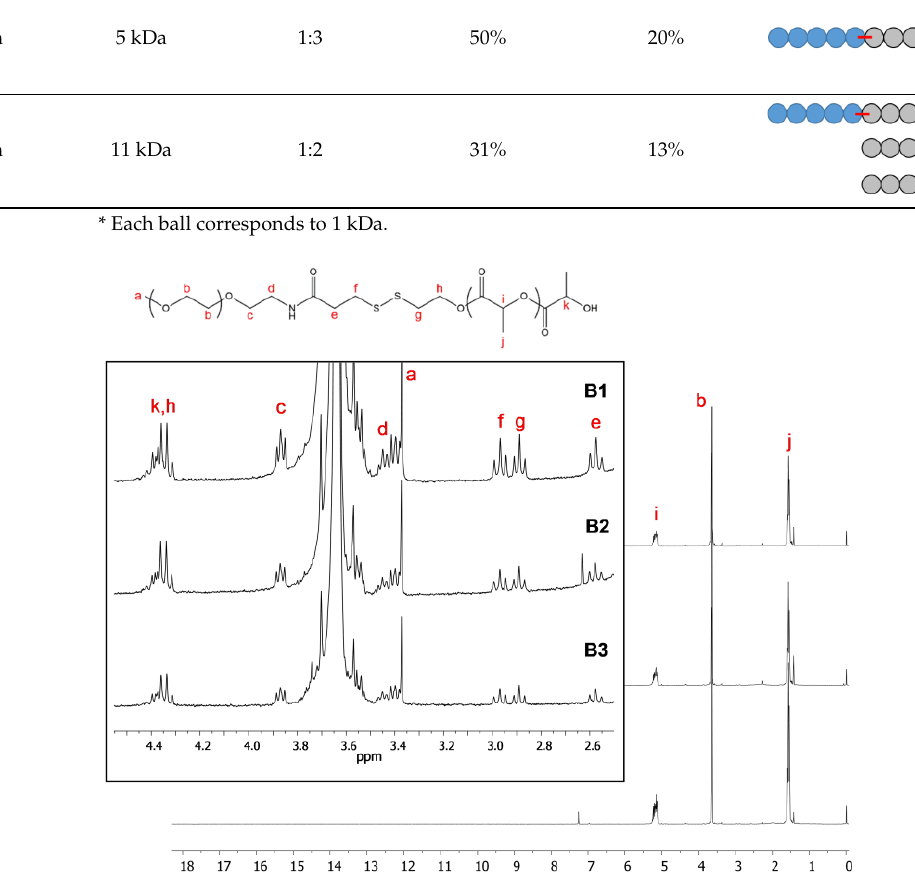
Figure 1. Synthesis scheme of the amphiphilic redox-responsive blends [19].